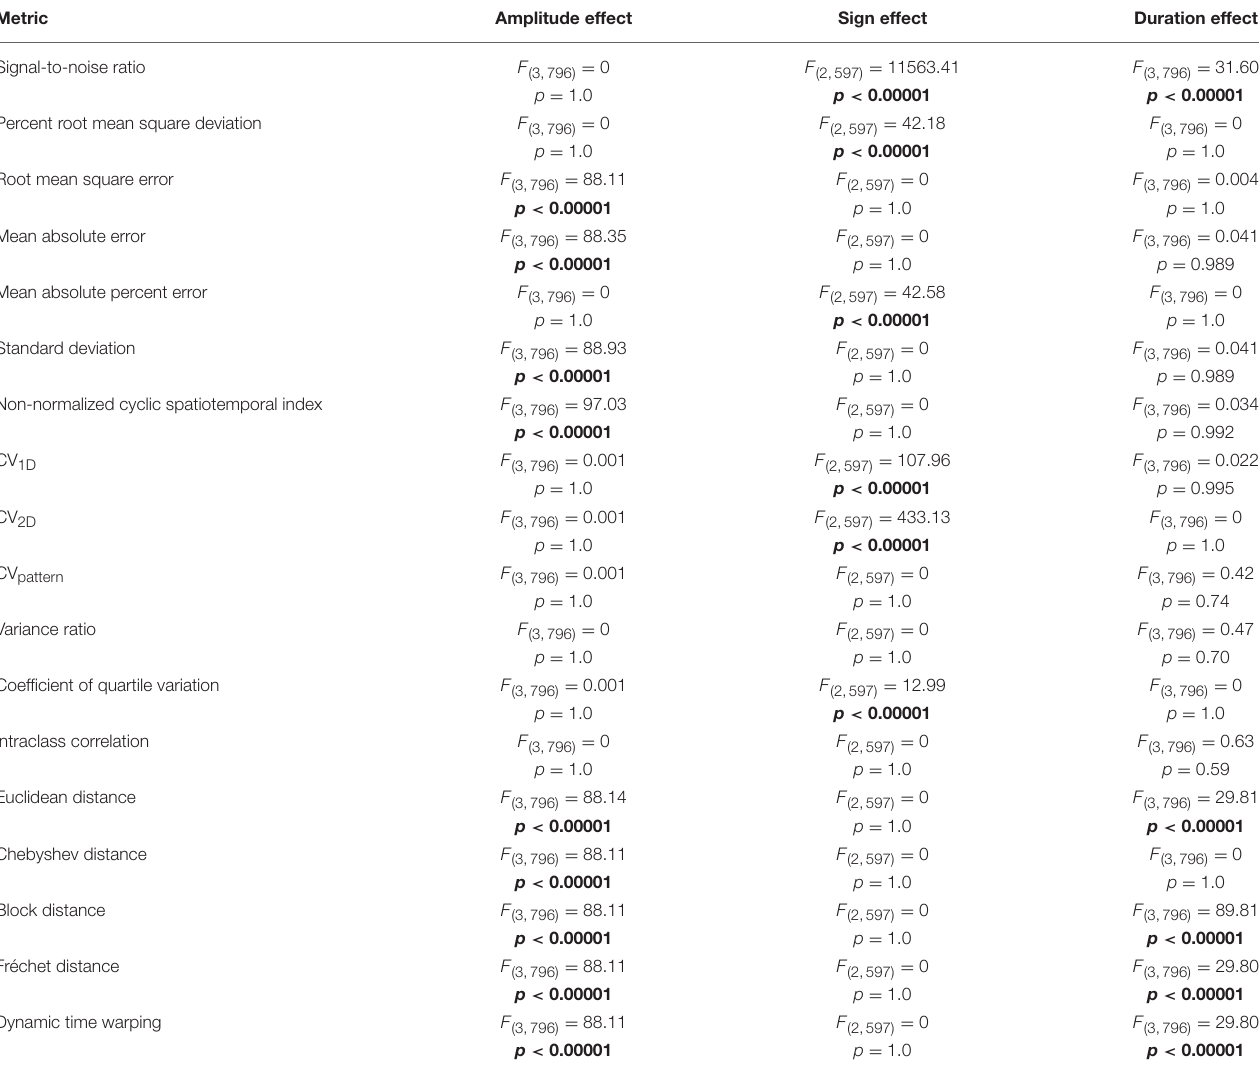
TABLE 1 | ANOVA results comparing effect of waveform amplitude, waveform sign, and waveform duration on the subset of variability metrics that are sensitive to amplitude, duration, and shape permutations. Metric